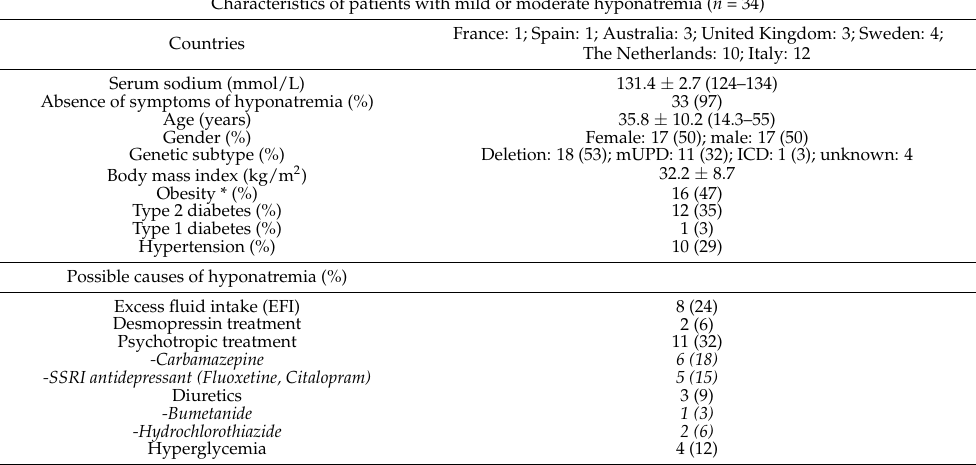
Table 2. Cases of mild or moderate hyponatremia in patients with Prader–Willi syndrome from seven